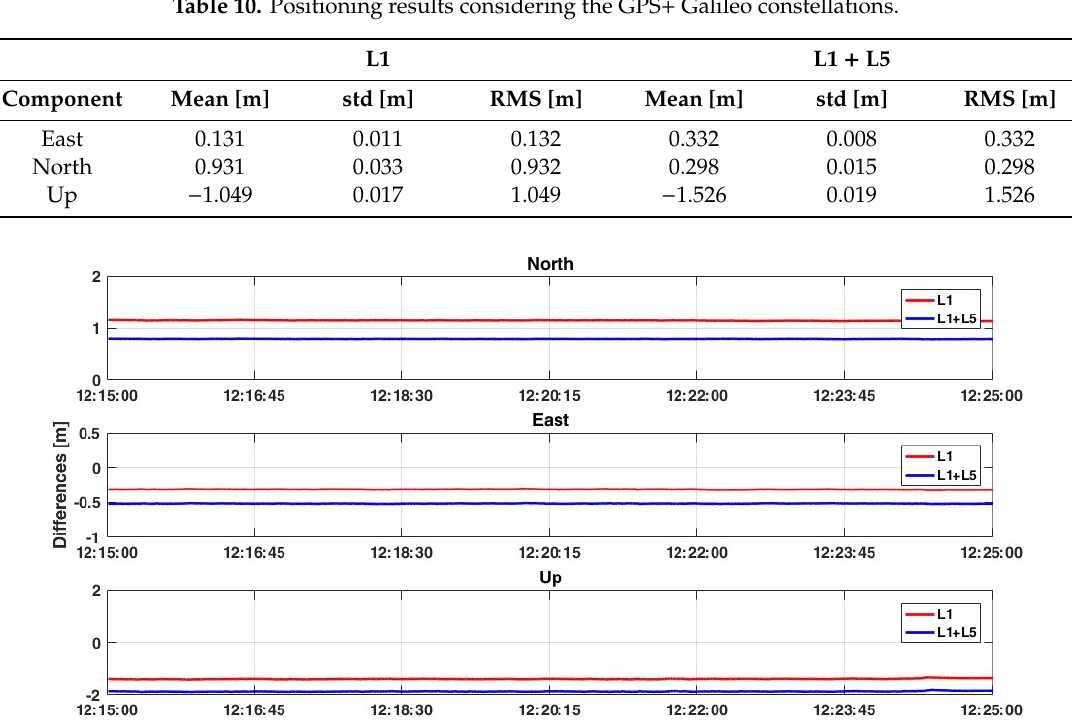
Table 7. Positioning results considering the GPS-only constellation. Table 10. Positioning results considering the GPS + Galileo constellations.